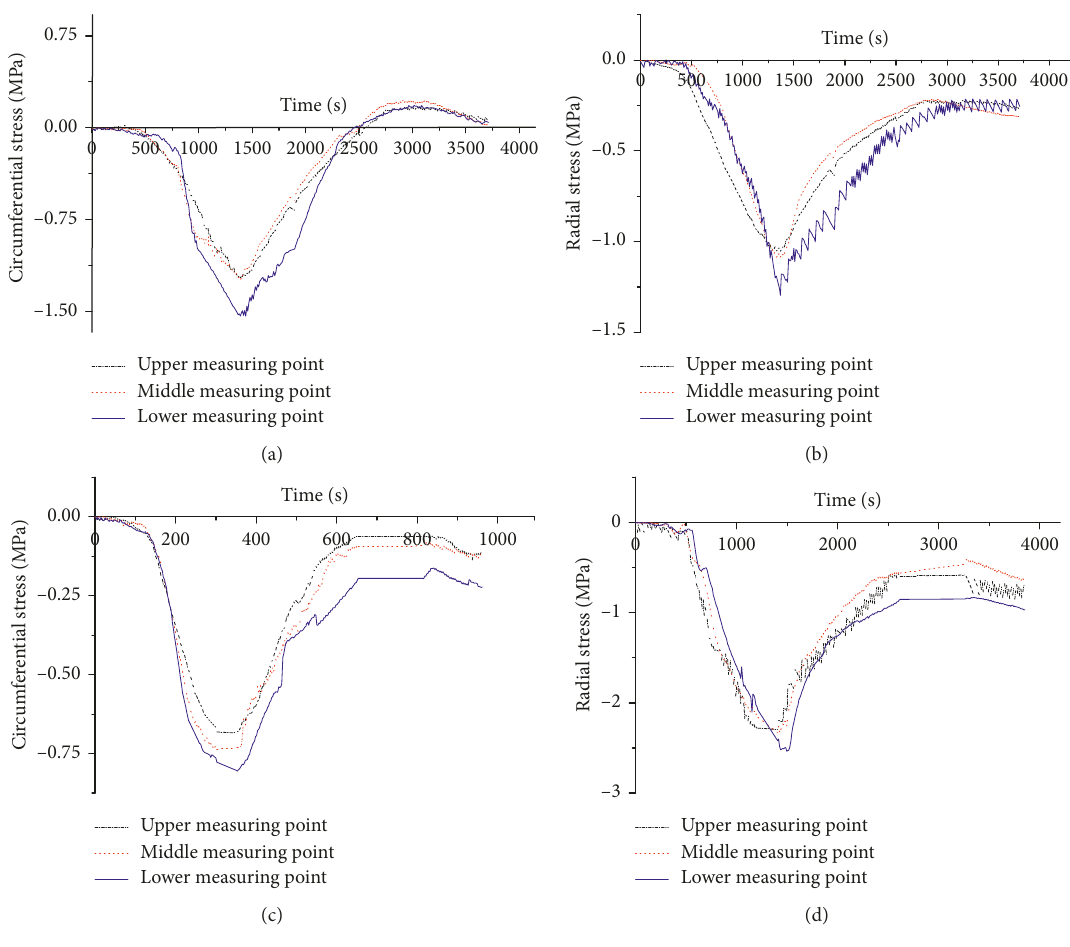
Figure 9: Stress curves for different heat source temperatures. (a) Circumferential stress: 90 ° C. (b) Radial stress: 90 ° C. (c) Circumferential stress: 60 ° C. (d) Radial stress: 60 ° C.